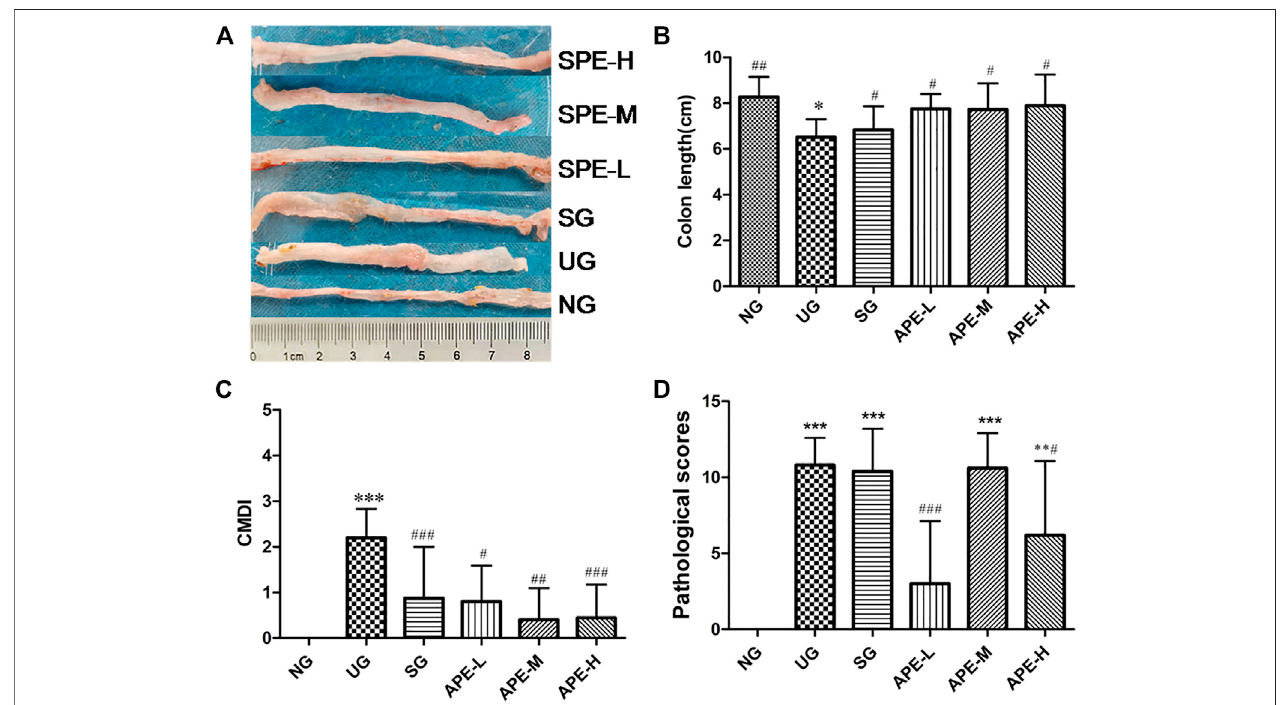
FIGURE4| EffectsofAPEoncolonlength,CMDIandpathologicalscores. (A) Representativeimagesofcolonsectionsfrommiceineachgroup. (B) Quanti fi cation of the change in colon length in each group. (C) The change of CMDI in each group. (D) The pathological scores in each group. n (cid:2) 10 for each group.** p < 0.01,*** p < 0.001vs.NG. # p < 0.05, ## p < 0.01, ### p < 0.001 vs. UG.APE, Alhagi pseudalhagi extract; CMDI, colon macroscopic damage index; NG, normal group; UG, ulcerative colitis model group; APE-H, high-dose APE group; APE-M, middle-dose APE group; APE-L, low-dose APE